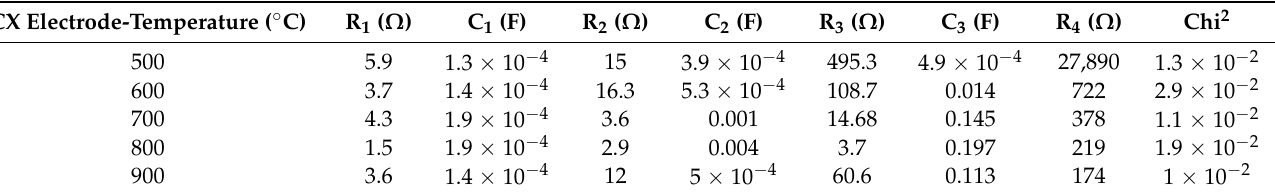
Table 3. Effect of carbonisation temperature on converged values of circuit-fitting parameters obtained from EIS data for CX